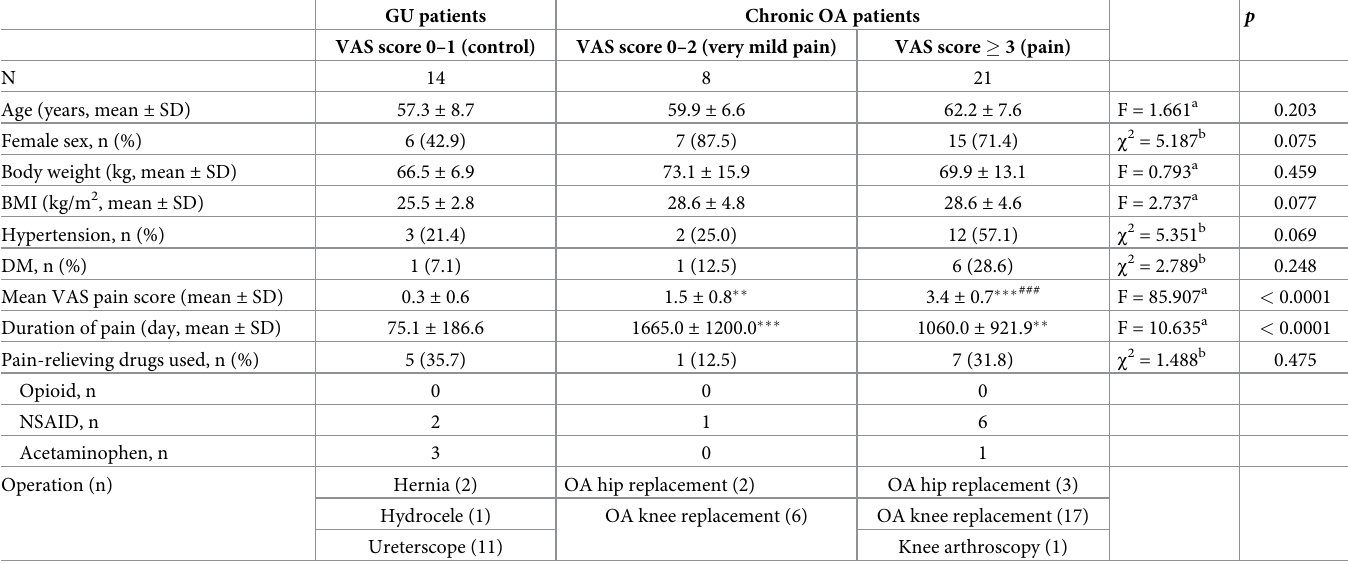
Table 1. Comparison of the general clinical parameters for the patients.